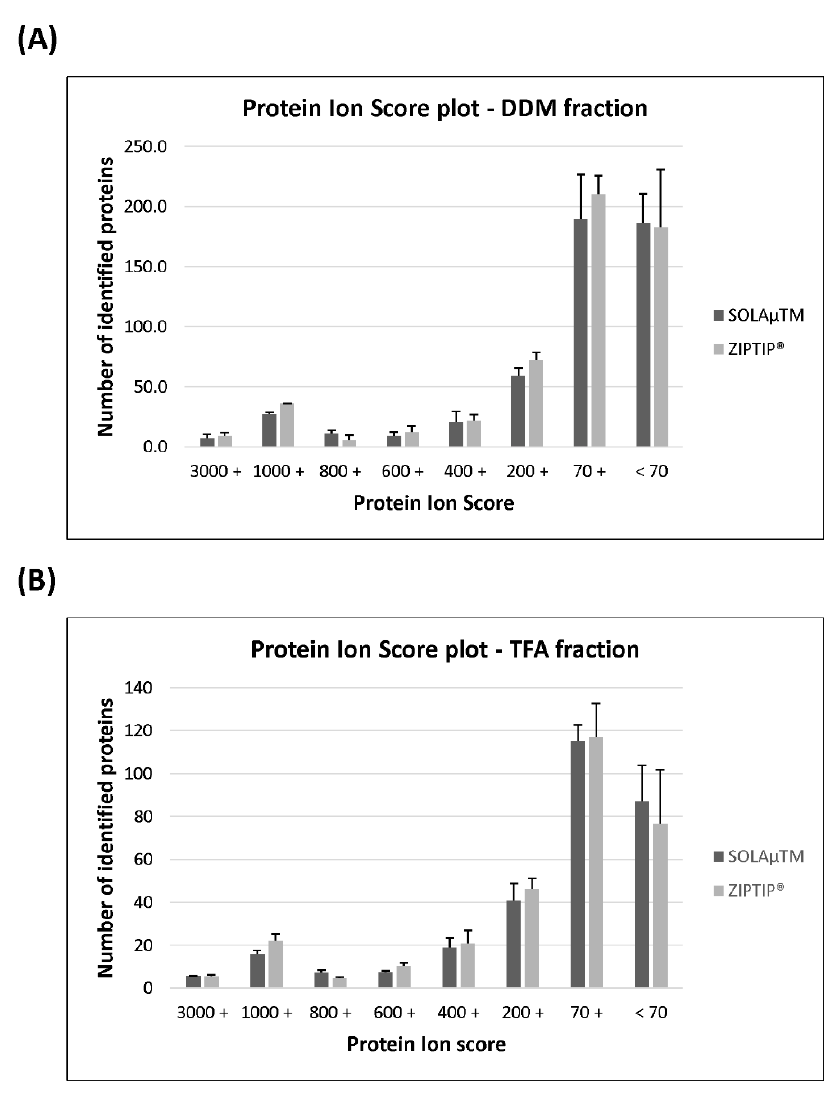
Figure 2. Distribution plot shows the classification of the identified proteins according to their specific protein ion scores. Proteins were clustered to the protein ion scores in the range of ≥ 3000, <3000 to ≥ 1000, <1000 to ≥ 800, <800 to ≥ 600, <400 to ≥ 200, <200 to ≥ 70 and <70. ( A ) Ion score distribution plot of the identified proteins in the DDM fraction after enrichment with to different solid phase extraction (SPE)-based purification methods (SOLA µ TM and ZIPTIP ® ). ( B ) Distribution profile of the identified proteins in the TFA fraction according to their specific ion scores after enrichment with two different SPE methods.